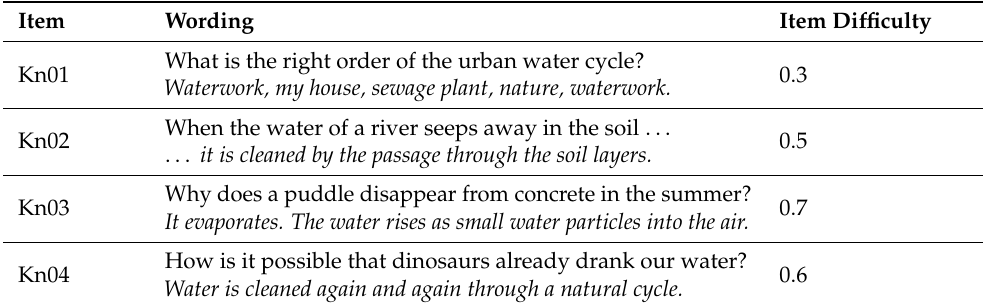
Table 2. Item examples of the knowledge scale translated to English. Only the correct answers are